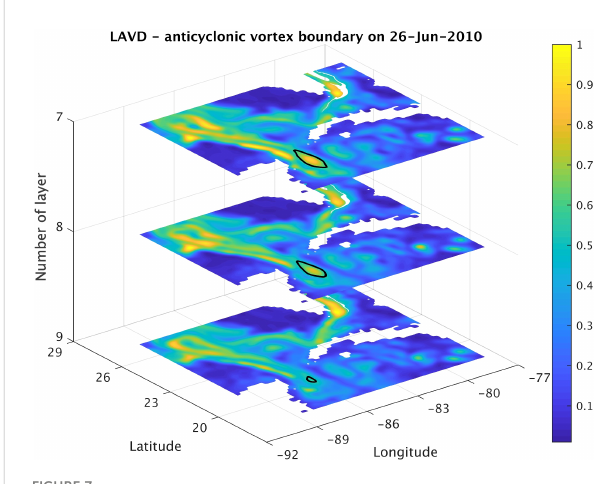
FIGURE 6 Occurrence frequencies of the PV fl uxes (%) presented in Figure 5 for retracted (blue) and extended (red) LC phases.